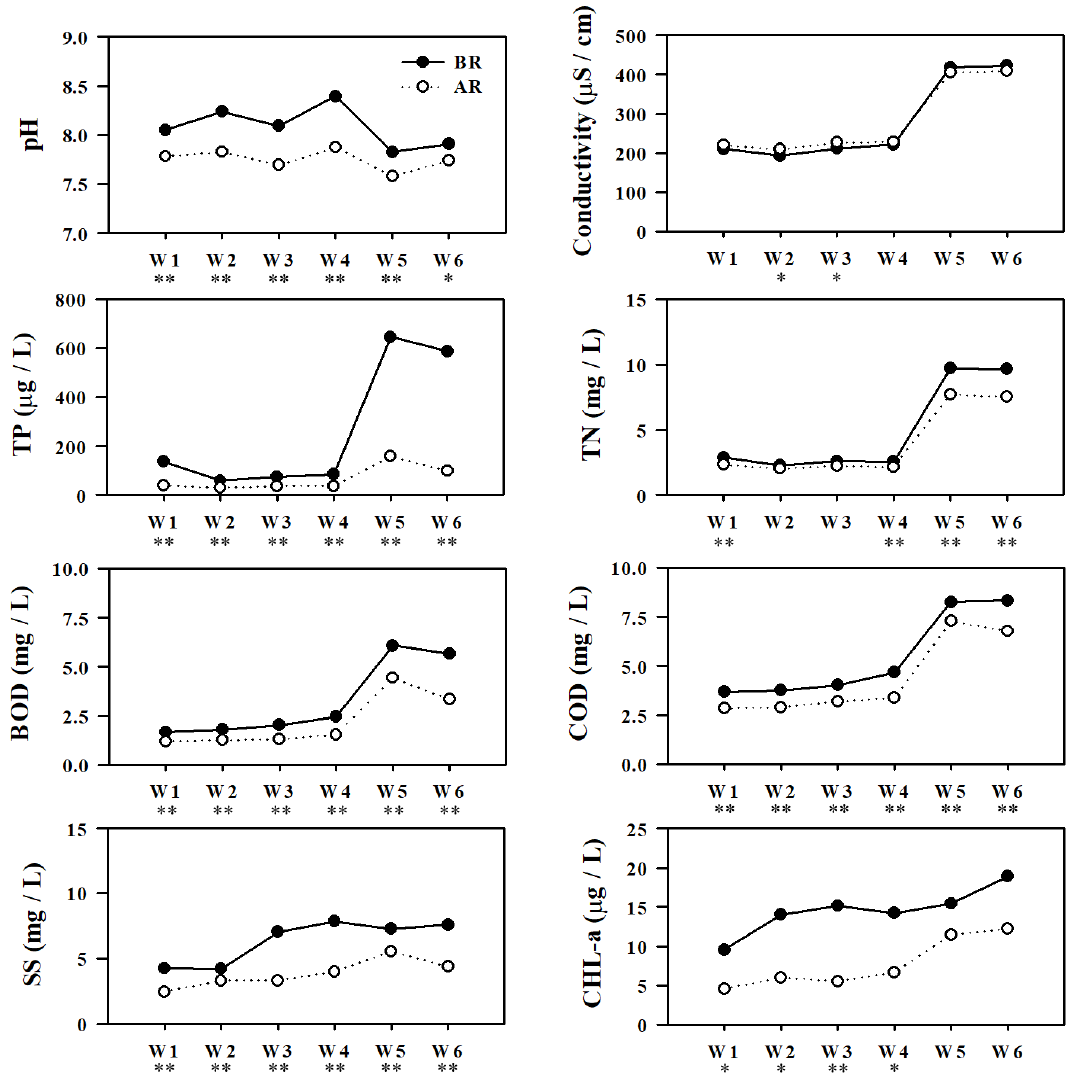
Figure 4. Comparison of water quality parameters to estimate the effect of restoration measures in Gap-stream (BR = before restoration, 2007–2010; AR = after restoration, 2013–2016, * = p < 0.05, ** = p < 0.01).